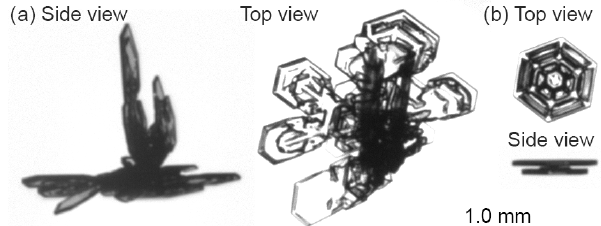
Figure 2. Two examples of ice crystals imaged in two viewing geometries: top view and side view. The ice crystal shown in panel (a) has a width of approximately 1.2mm; the one in panel (b) has a width of 0.4mm. Both ice crystals in panels (a) and (b) use the same scaling; for reference, a size bar with length corresponding to 1mm (and width of 10µm) is shown.